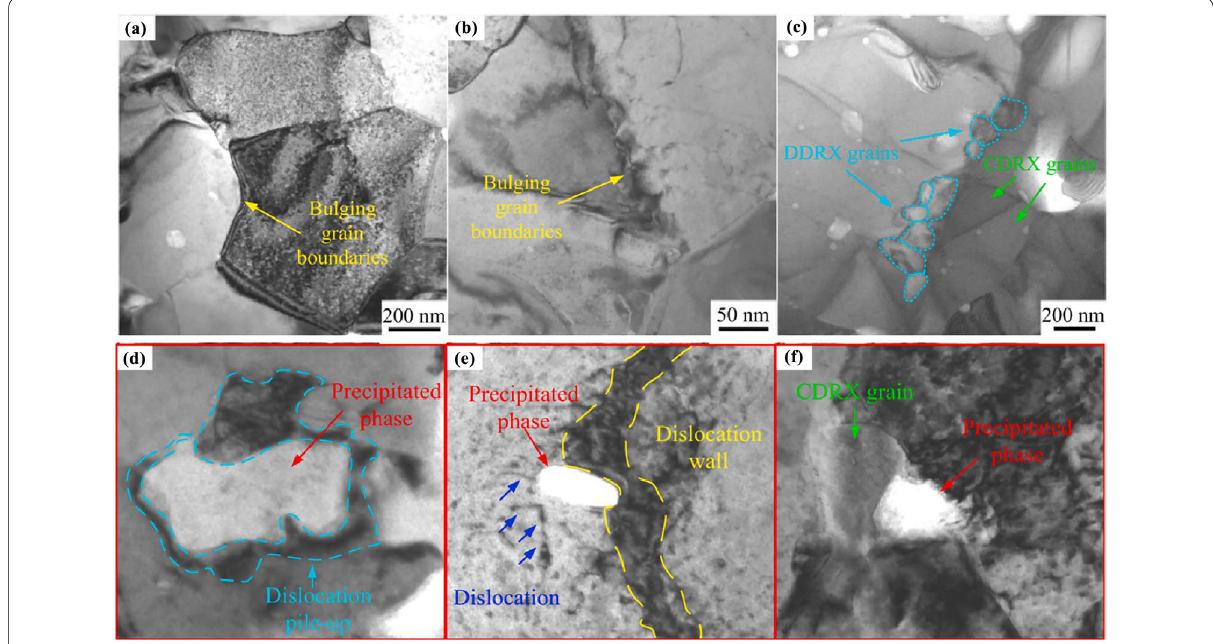
Figure 19 TEM images of deformed MoNbTaTiV RHEA [90] ( a ) and ( b ) bulging GBs, ( c ) DDRXed grains and CDRXed grains, ( d ) precipitates at GBs, ( e ) precipitates in the grain, ( f ) precipitates at the trigeminal